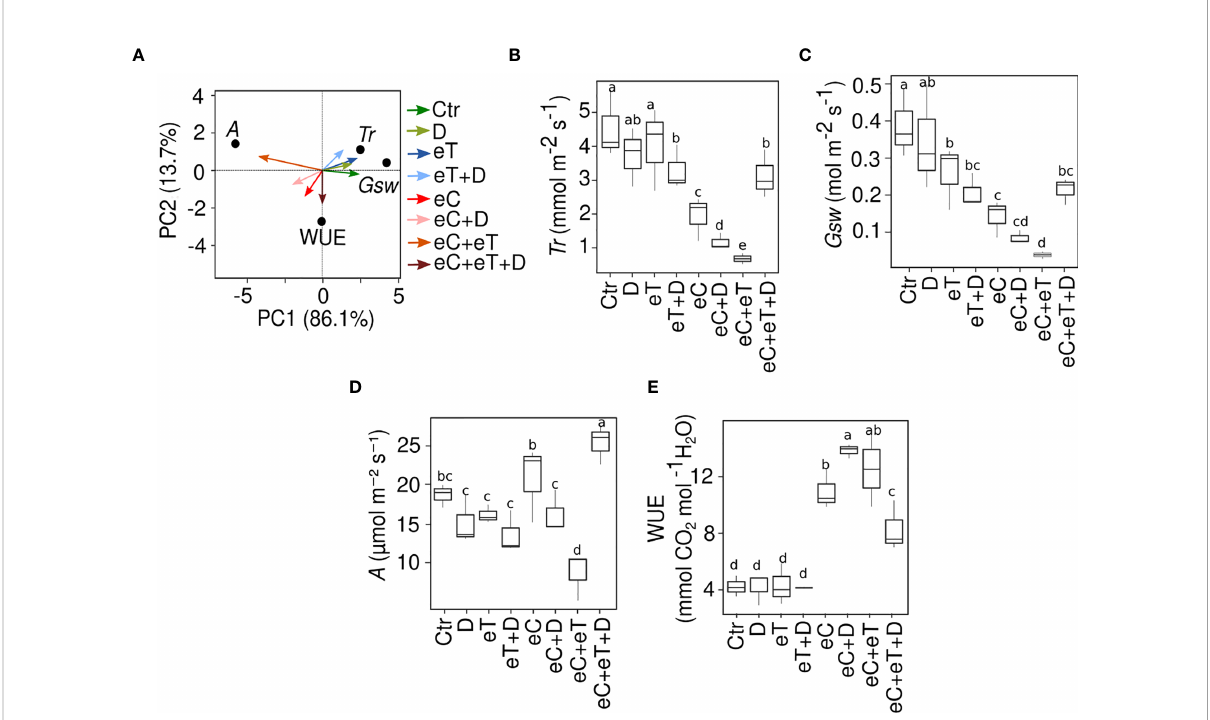
FIGURE 2 Impact of single and multiple climate variables on the physiology of wheat cv. Cadenza in tillering stage. (A) Principal component analysis plot of the physiological traits measured at 25 DPT. An account of (B) Transpiration rate, Tr ; (C) Stomatal conductance, Gsw ; (D) Rate of photosynthesis, A ; (E) Water use ef fi ciency, WUE, under single and combined climate variable treatments. Three biological replicates ( n =3) per treatment were used to evaluate the physiological traits. The box plot shows the inter-quartile range with the mean. Values marked with the same letter do not differ according to Tukey ’ s test multiple range tests ( P ≤ 0.05). Ctr, control treatment; eC, elevated CO 2 ; eT, elevated temperature; D, drought; eC+eT, elevated CO 2 and elevated temperature; eC+D, elevated CO 2 , and drought; eT+D, elevated temperature, and drought; eC+eT+D, elevated CO 2 , elevated temperature, and